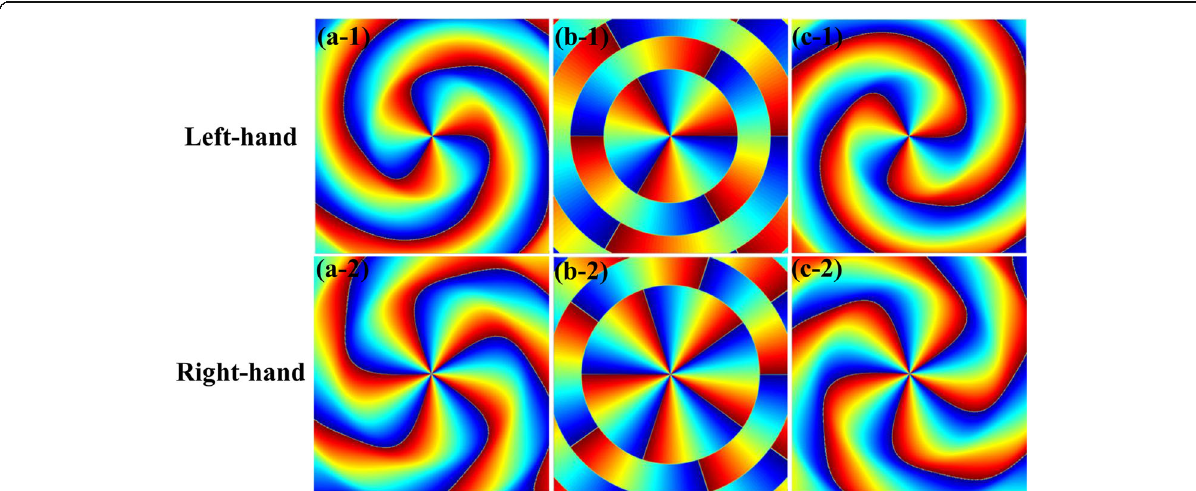
Fig. 4 Phase profile of the longitudinal component of CPAVBs with m = 4 near the focus. The first and second rows are the left-hand and right-